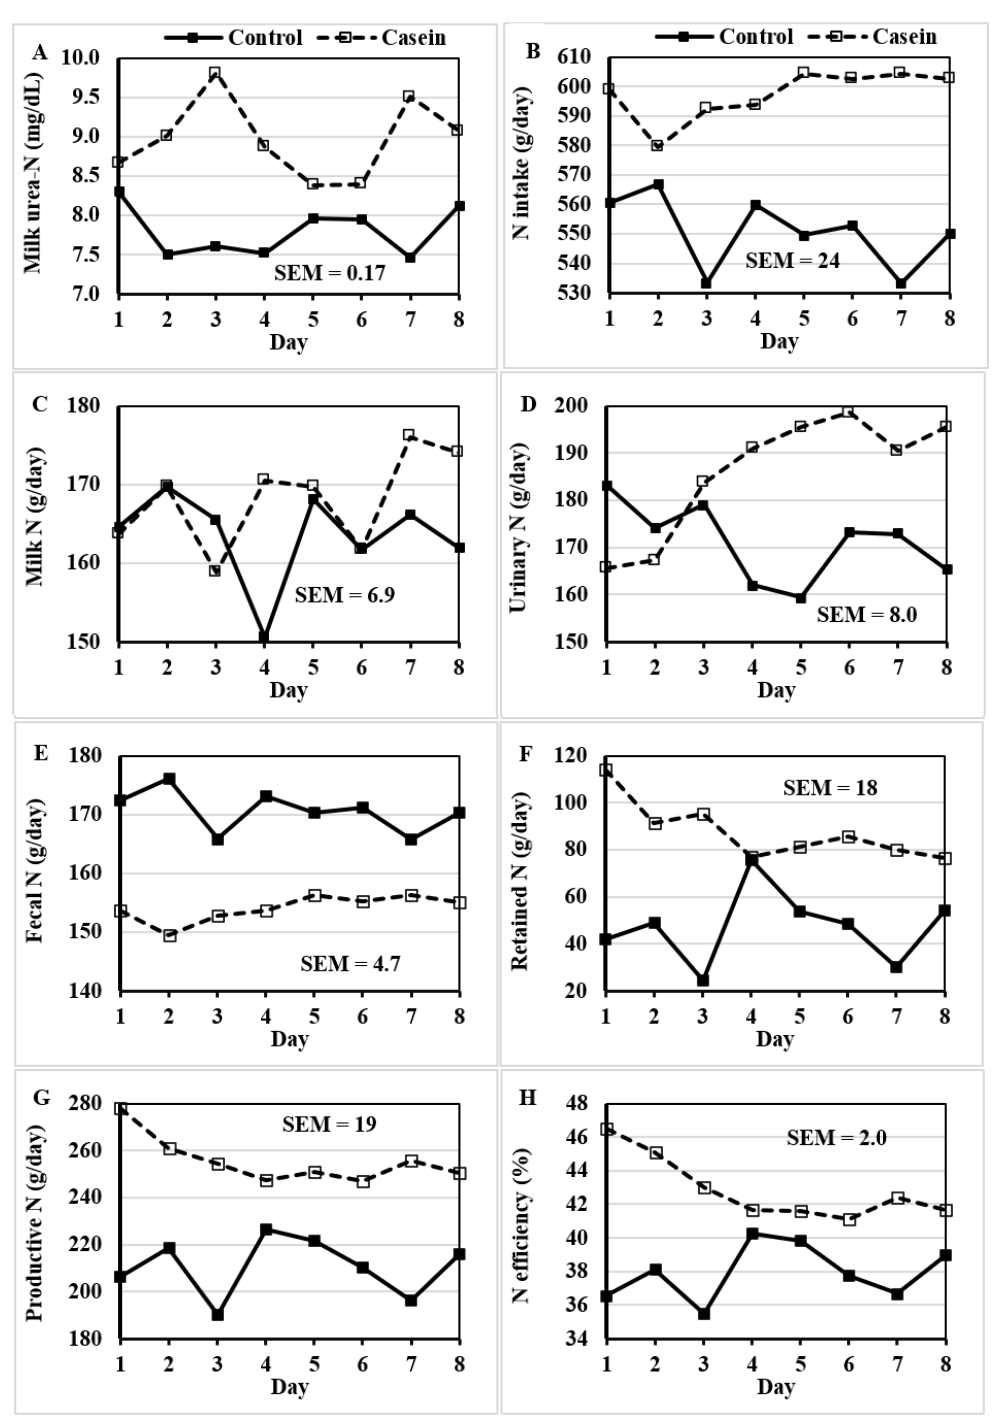
Figure 1. Effect of casein supplementation on milk urea-N and measures of N use from days 1 through 8 of each period. ( A ) milk urea-N: casein, p < 0.001; casein × day, p = 0.61. ( B ) N intake: casein, p < 0.001; casein × day, p = 0.33. ( C ) milk N secretion: casein, p = 0.08; casein × day, p = 0.75. ( D ) urinary N excretion: casein, p < 0.001; casein × day, p = 0.06. ( E ) fecal N excretion: casein, p = 0.01; casein × day, p = 0.31. ( F ) retained N: casein, p < 0.001; casein × day, p = 0.06. ( G ) productive N: casein, p < 0.001; casein × day, p = 0.21. ( H ) N efficiency: casein, p = 0.001; casein × day, p = 0.09.